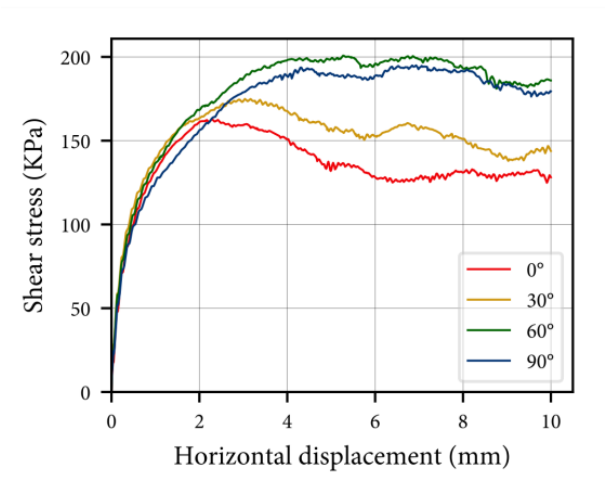
Figure 8. Stress–horizontal displacement curves of FRS with different fiber orientations (0°, 30°, 60°, and 90°).